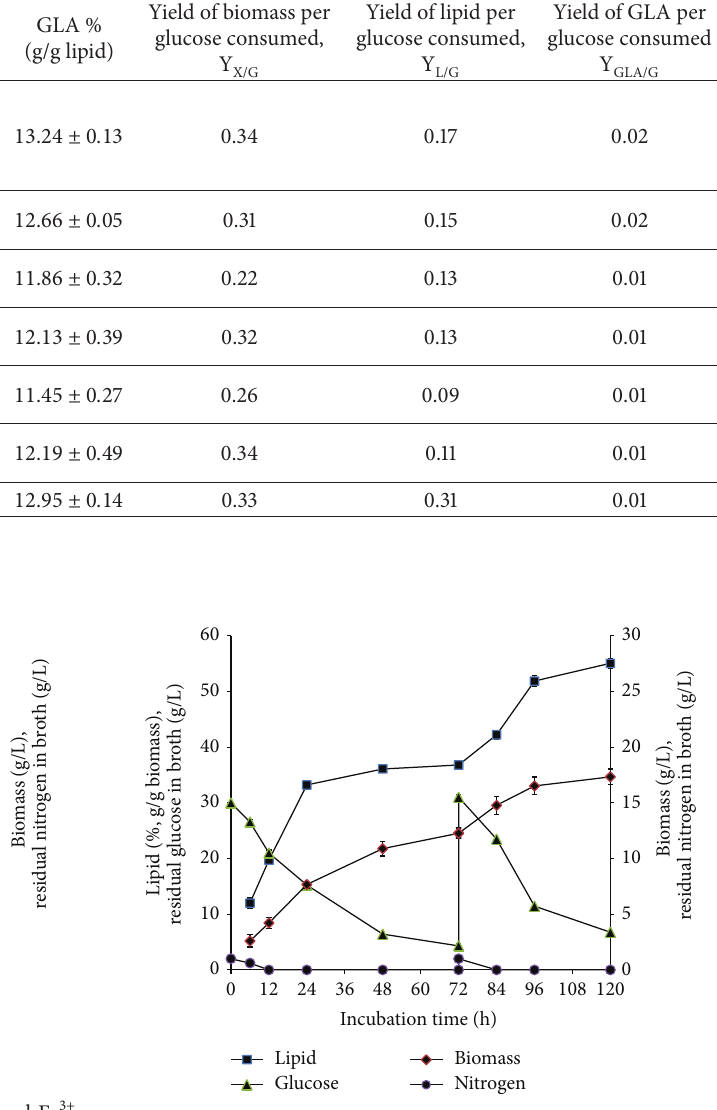
Figure 6: Effect of feeding ammonium tartrate, glucose, and Fe 3+ at 72 h in lipid accumulation of C. bainieri 2A1. The culture was cultivated in a 5L fermenter with 4 L of nitrogen-limited medium starting inoculums of 10% (v/v). The data represent means ± SDs, 𝑛 = 3